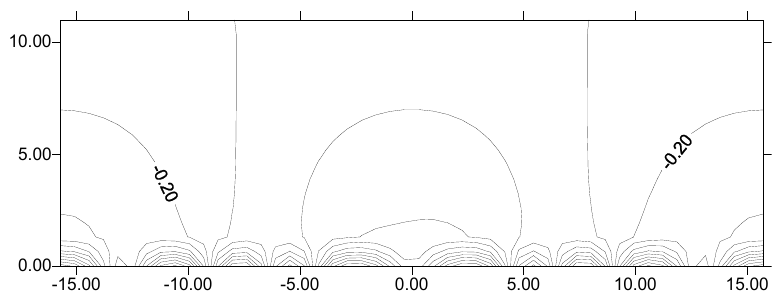
Figure 6. Mixed regime: the superposition of finite-wavelength and longwave modes.